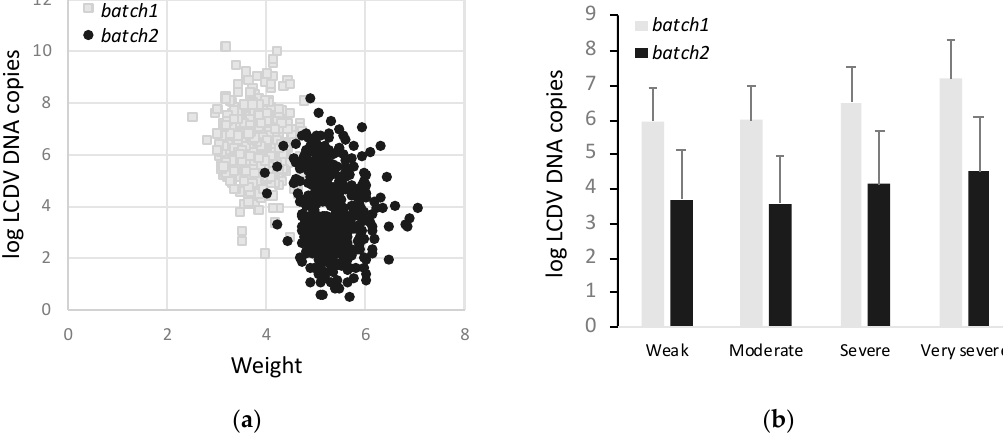
Figure 4. Lymphocystis disease virus (LCDV) DNA copies in logaritmic scale for batch 1 and batch 2. ( a ) DNA copies as function of weight; ( b ) DNA copies as function of four SI categories.